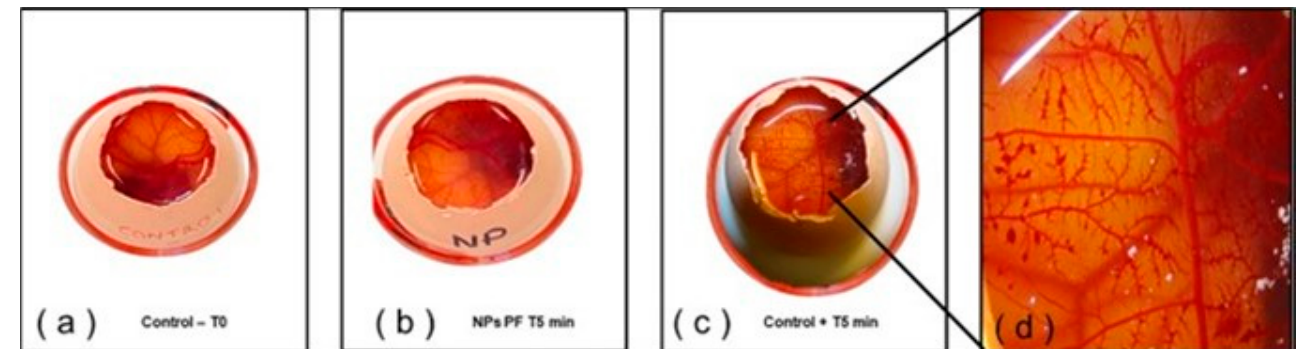
Figure 10. HET-CAM test: ( a ) Saline solution (Negative control-free PF-NPLCs); ( b ) PF-NPLCs-N6; ( c ) 0.1 N sodium hydroxide (Positive control); and ( d ) lesions caused by the positive